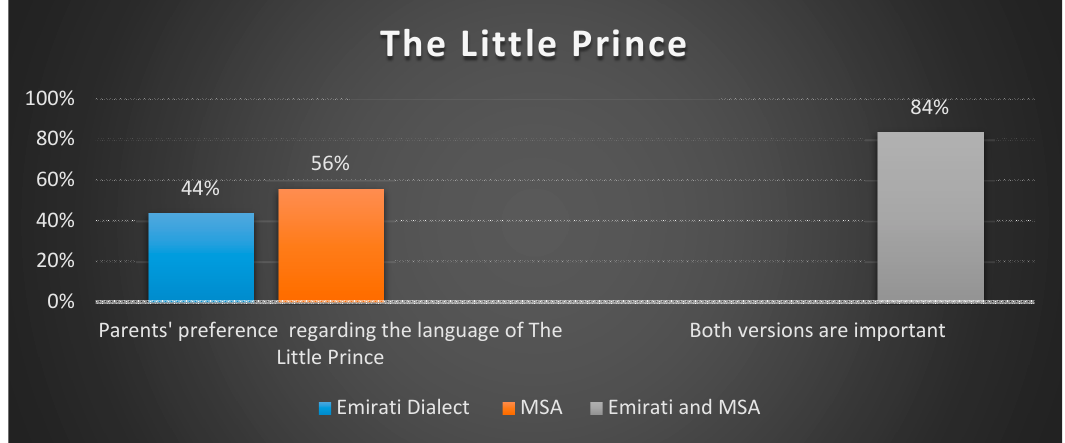
Figure 4. The Little Prince in MSA or Emirati Dialect.